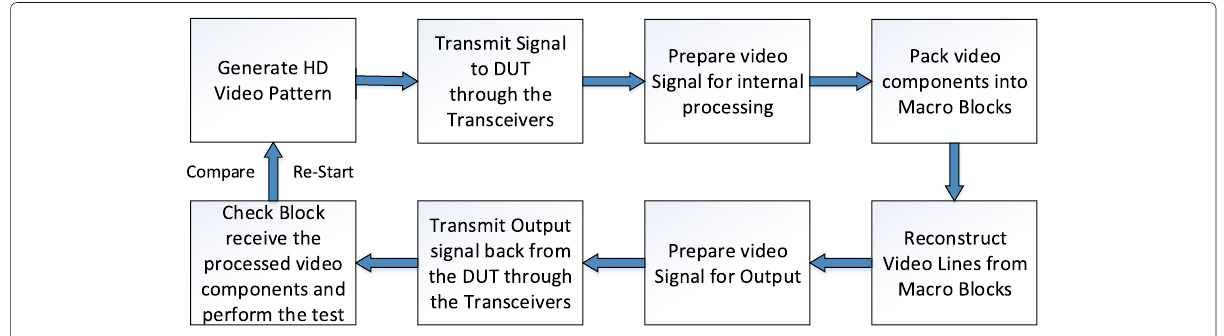
Fig. 5 Complete chain functionality block diagram